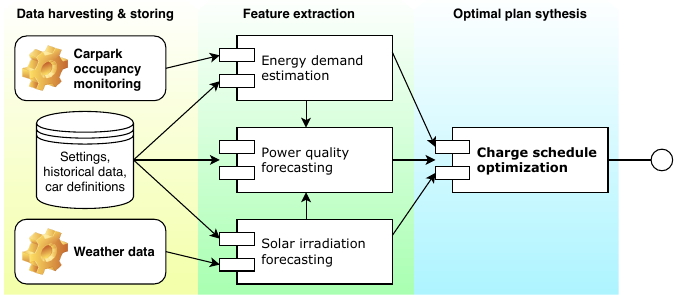
Figure 3. A UML diagram of an intelligent decision making system controlling the charge schedule in automated multistory